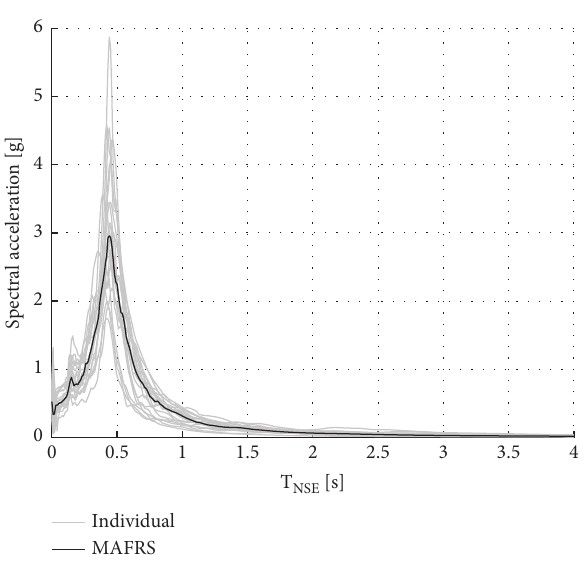
Figure 7: AFRS obtained by means of NLTHAs.